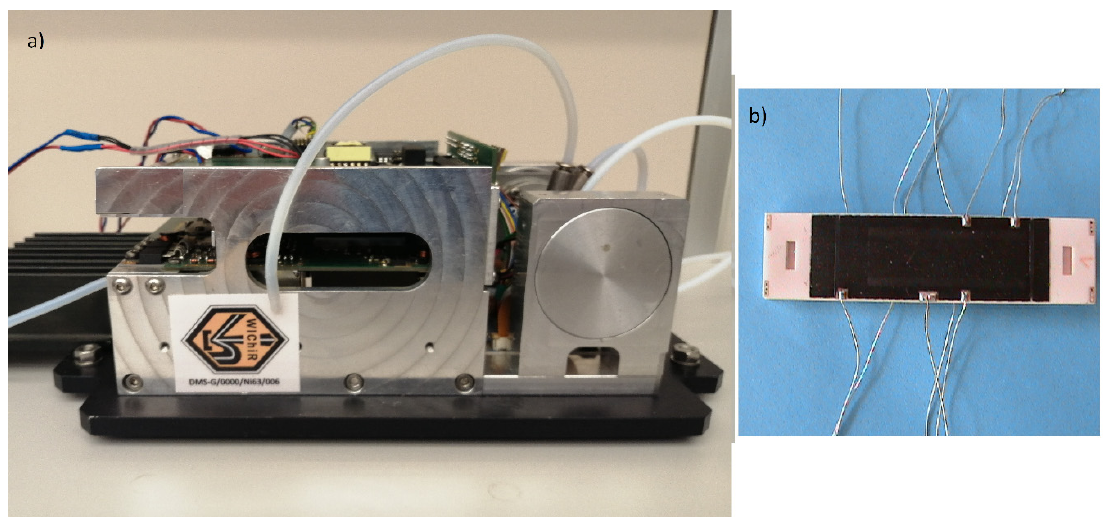
Figure 4. ( a ) DMS spectrometer; ( b ) ceramic DMS chamber.